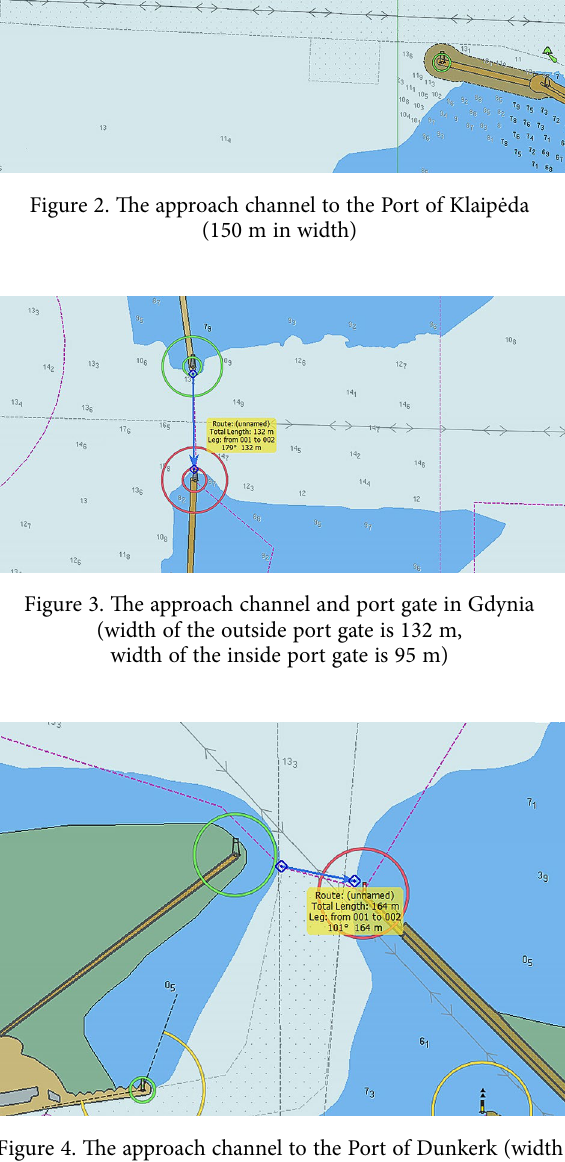
Figure 4. The approach channel to the Port of Dunkerk (width of the port gate is 164 m with a short area for ship